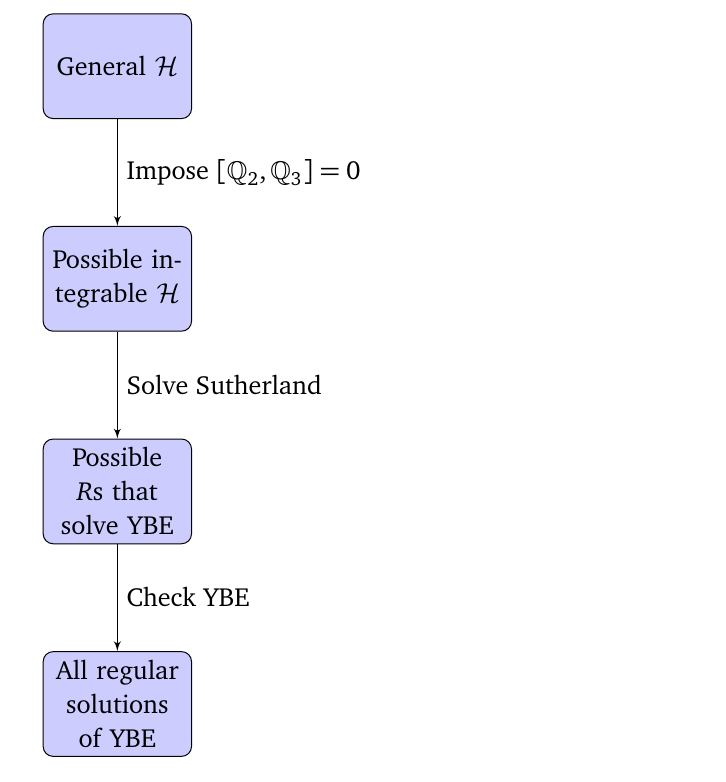
Figure 1: Flowchart of determining regular solutions of the Yang-Baxter